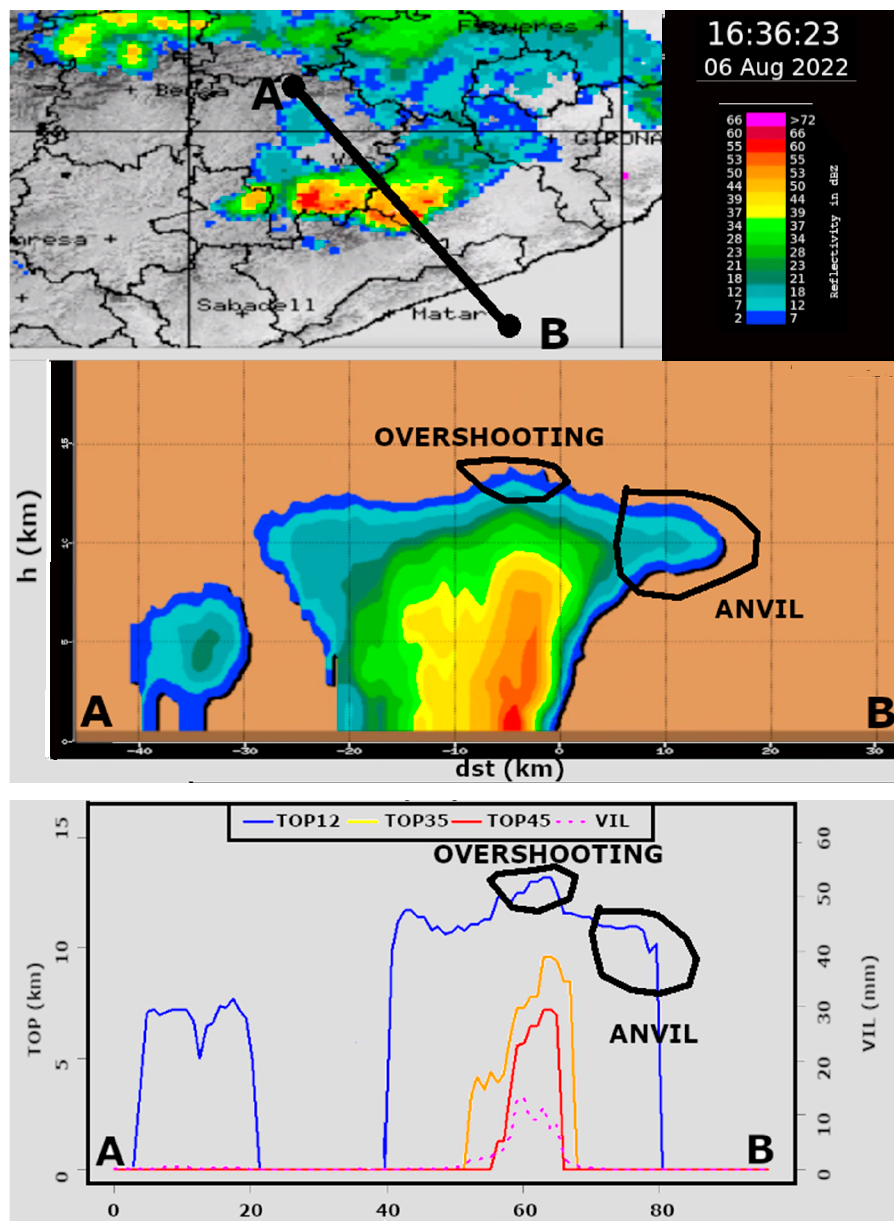
Figure 2. ( Top ). Partial view of the CAPPI at 2 km on 6 August 2022 at 1636 UTC. The black segment marked with “A” and “B” is used in the mid and bottom panels of the figure. The two columns of the reflectivity color bar indicate the minimum and the maximum reflectivity for each color. ( Middle ). Cross section of the reflectivity over the segment “A”–“B”. The solid black line polygons indicate the Overshooting of the thunderstorm and the area inside the quadrilateral corresponds to the anvil of the same cloud. ( Bottom ). Estimation of the TOP12, TOP35 and TOP45 (blue, yellow, and red solid lines) and of the VIL (purple dashed line) for the same cross-section of the central panel. The x -axis label (“dst (km)”) of the mid and bottom panels indicates the distance along the segment, but the origin is different (the 0 in the mid panel is the leading part of the thunderstorm, and in the bottom is the A point). The left y -axis title of the same panels corresponds to the height of the reflectivity echoes (“h”), mid panel, and the height of the different Echo Top (“TOP”) products (TOP12, TOP35 and TOP45), bottom panel.